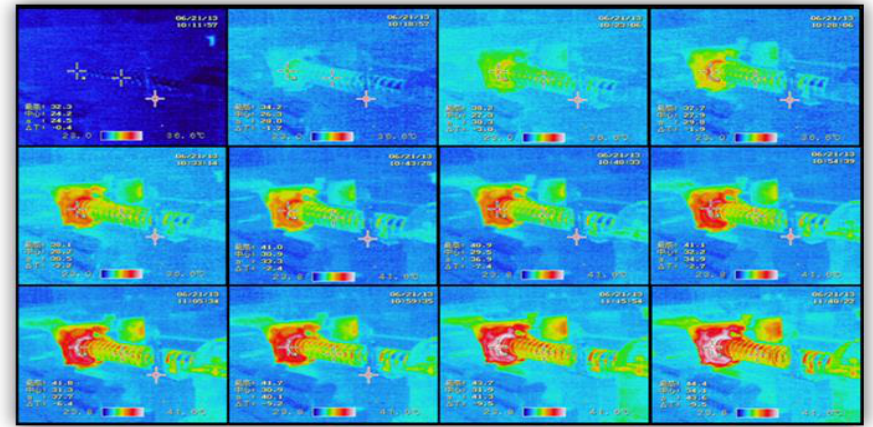
Figure 3. Motor current plot of the 4% ball-screw preload without pretension and with a 20-kg payload under a repetitive motion speed of 600 rpm for 60 min. The blue and red colors indicate the conditions with and without oil-cooling circulation, respectively.